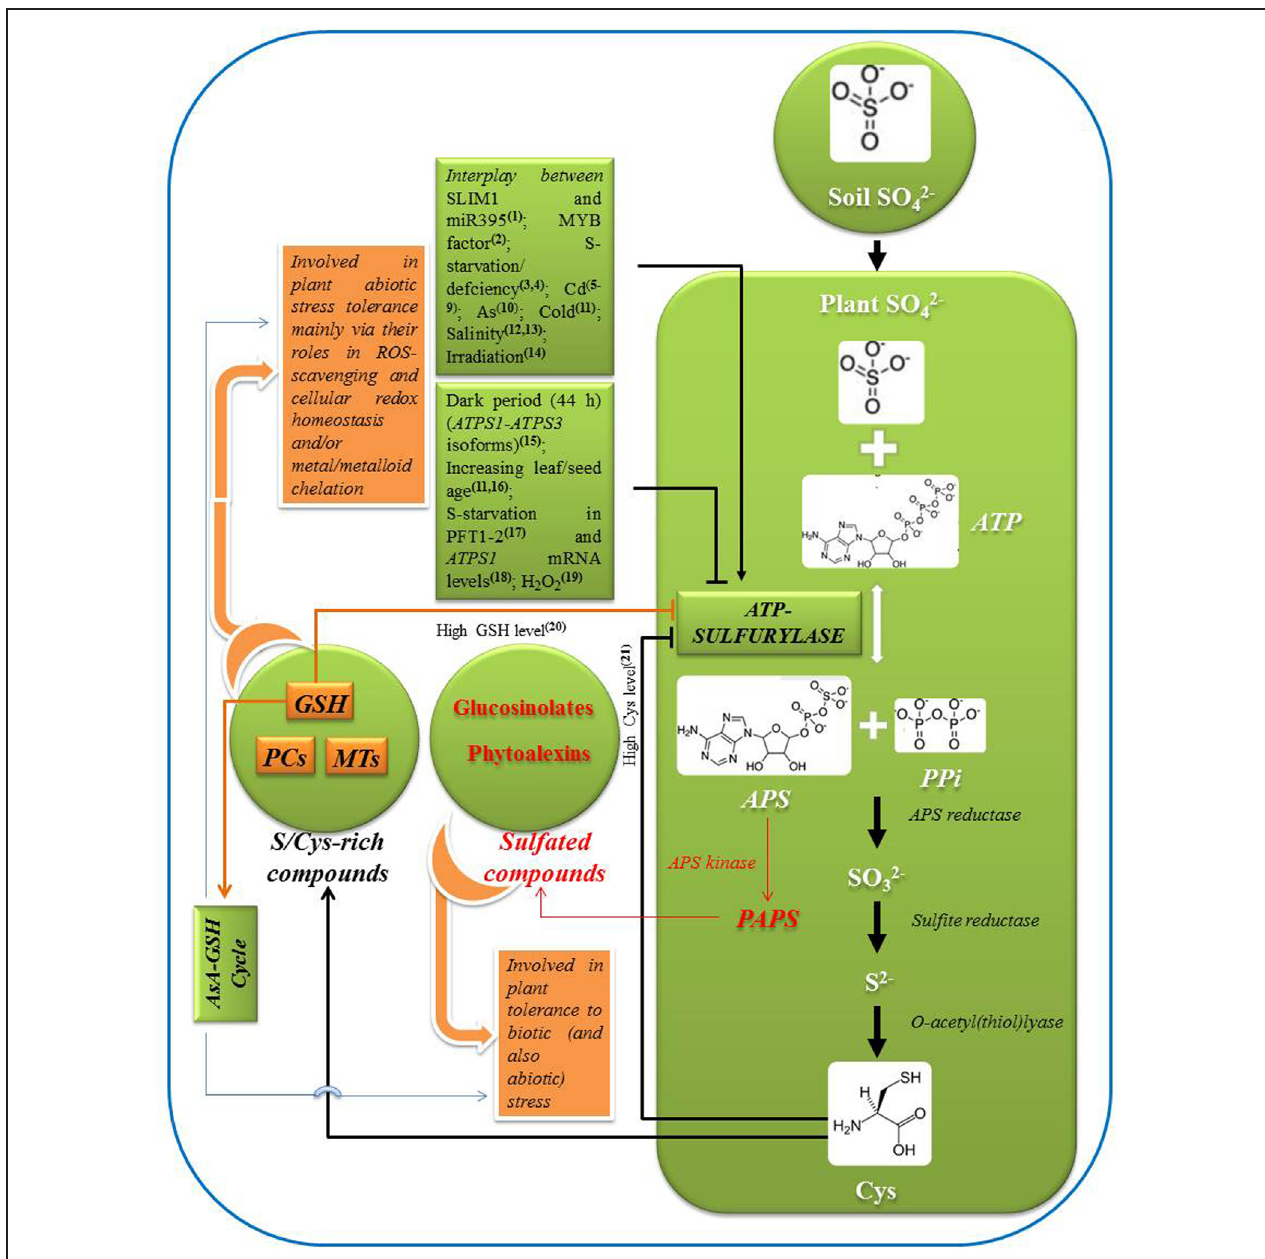
FIGURE 1 | Schematic representation of pathway of sulfate assimilation, reaction catalyzed by ATP-sulfurylase (ATP-S), and its regulation by major factors. Role of ATP-S in plant stress tolerance through sulfur/cysteine rich and sulfated compounds is outlined. Positive and negative regulation of ATP-S is indicated by arrows and blunt ends, respectively, [ 1 Kawashima et al. (2011); 2 Yatusevich et al. (2010); 3 Hopkins et al. (2004); 4 Schiavon et al.